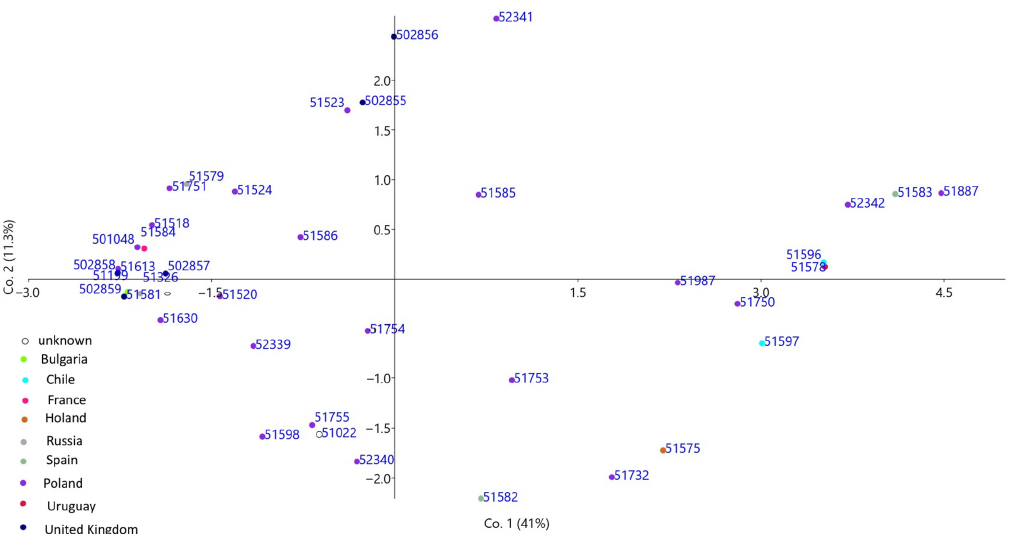
Figure 1. Principal component analysis of the Avena strigosa L. accessions. A scatter plot of PC1 (explaining 41% of the variance) versus PC2 (explaining 11.3% of the variance). Label colors indicate the origin countries of the samples.